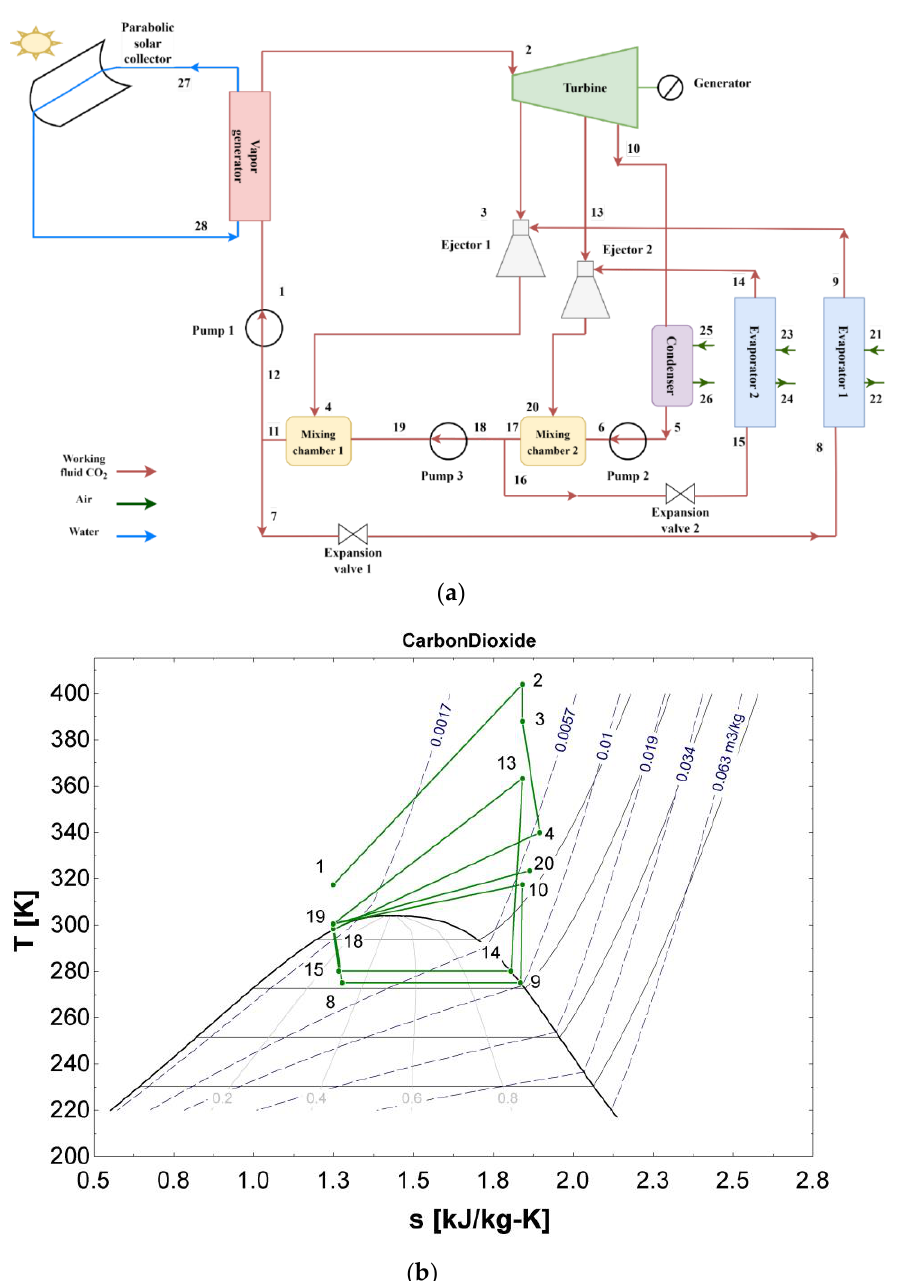
Figure 1. ( a ) Schematic of the CMCP system. ( b ) The T-s diagram of the CMCP cycle.